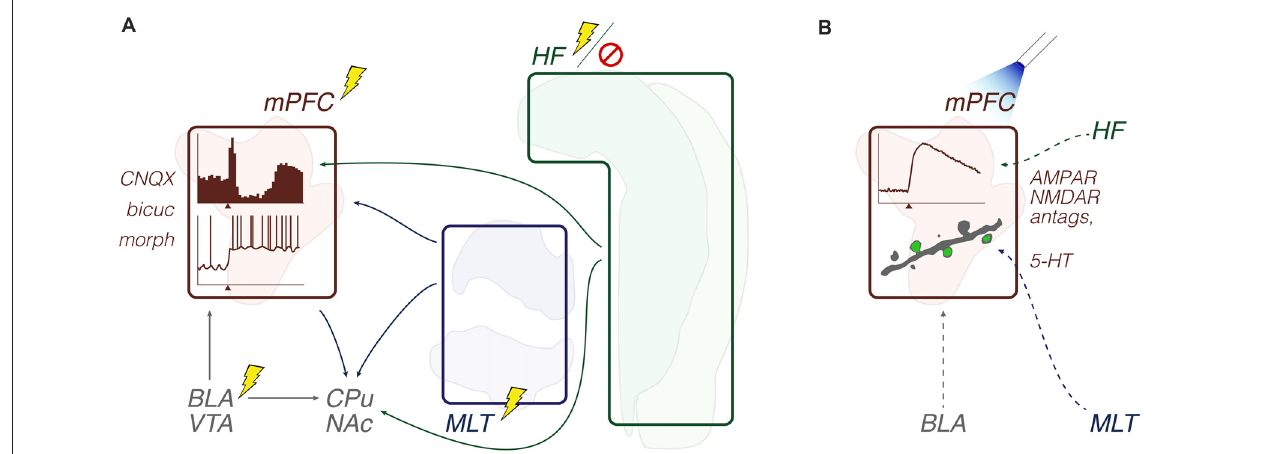
FIGURE 2 | Input convergence: methods and objects of study merged into a schematic summary. The figure portrays generic representations of techniques reviewed in the “Input convergence” subsection. Arrows from the HF are generically positioned, i.e., no distinction is made between dorsal, intermediate and ventral domains. Outlines of brain areas are based on Figure 1 . (A) In vivo electrophysiology, intracerebral electrical stimulation and pharmacological manipulations. Experiments evaluated the prefrontal and striatal concentration of inputs through recording evoked responses upon afferent electrical stimuli, including during drug effects. Lightning and forbidden sign icons represent electrical pulses and hippocampal lesion, respectively. Representative prefrontal cortical data: perievent rate histogram (top) and single-cell voltage trace (bottom) with x-axis arrowheads representing electrical stimuli (e.g., Gigg et al., 1994; Lewis and O’Donnell, 2000). (B) In vitro electrophysiology, optogenetics and pharmacological manipulations. Experiments evaluated the prefrontal concentration of inputs through recording evoked responses upon optogenetic triggering of glutamate release, including during drug effects. The beam icon represents blue light pulses for stimulation of channelrhodopsin-expressing presynaptic terminals (dashed arrows). Representative prefrontal cortical data: perievent current trace, and two-photon microscopy of a dendrite (gray) with evoked Ca 2 + signals (green; Little and Carter, 2012). Abbreviations: antags, antagonists; bicuc, bicuculline; BLA, basolateral amygdala; CPu, caudate-putamen; HF, hippocampal formation; MLT, midline/paramidline thalamus; morph, morphine; mPFC, medial prefrontal cortex; VTA, ventral tegmental area.